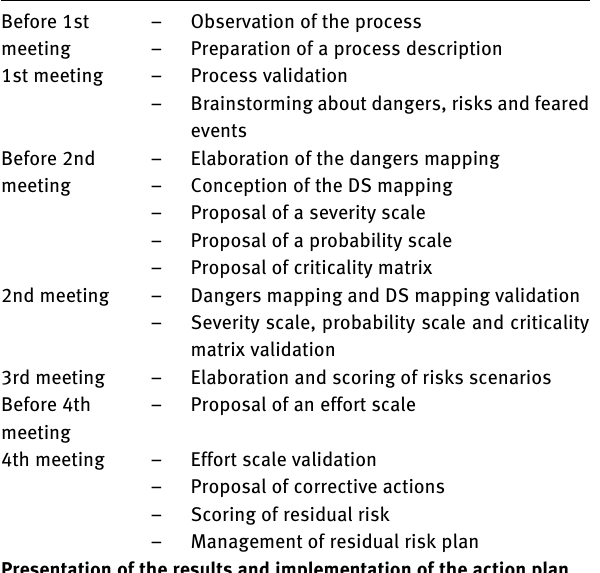
Table  : Projected organisation of